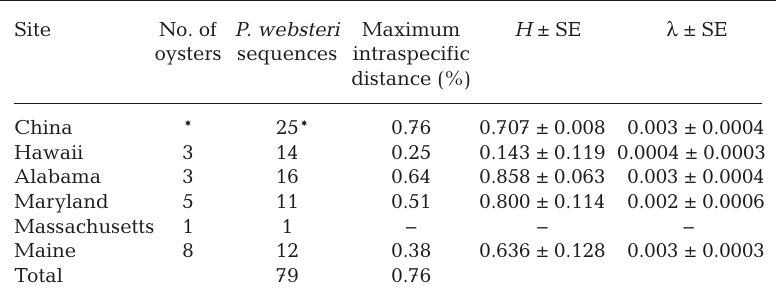
Table 1. A total of 79 P. websteri sequences were analyzed in this study, with a maximum of 25 sequences from China and a minimum of 1 sequence from Massa- chusetts, USA. Adult blister worms were sampled from multiple shellfish (no. of oysters) at all US sites except Massachusetts. *Ye et al. (2017) indicated that 200 oysters were sampled from a farm in Guangdong Province, China, but not the number of oysters from which adult worms were sampled, and their data also included sequences from P. websteri larvae. Estimates of maximum intraspecific divergence (%), haplotype diversity ( H ±1 SE) and nucleotide diversity ( λ ±1 SE) are presented for the sequences from each